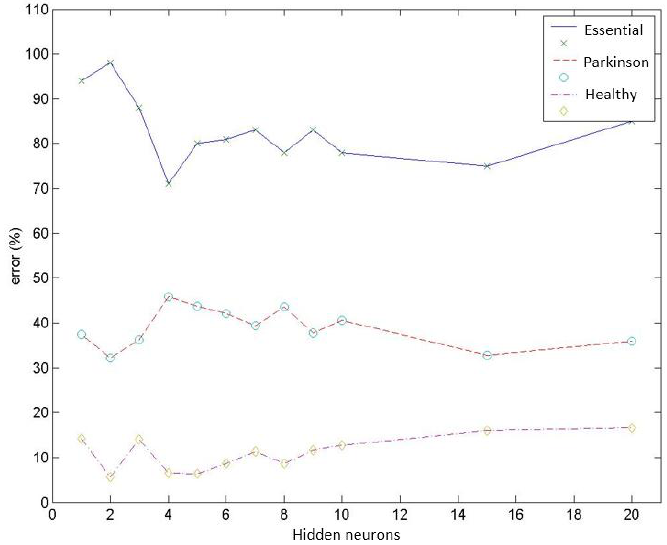
Figure 14. Error distribution for each type of pathology obtained using all available